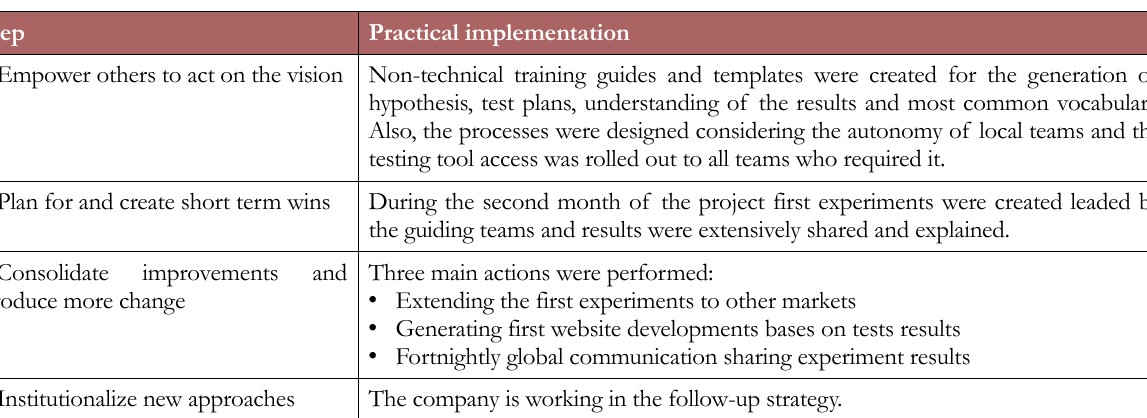
Table 2. Organizational change process